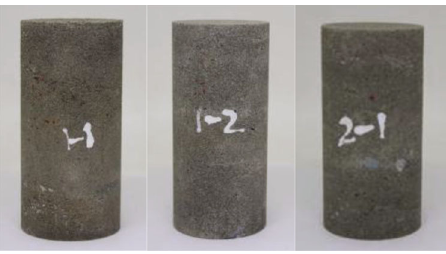
Figure 2: Sandstone